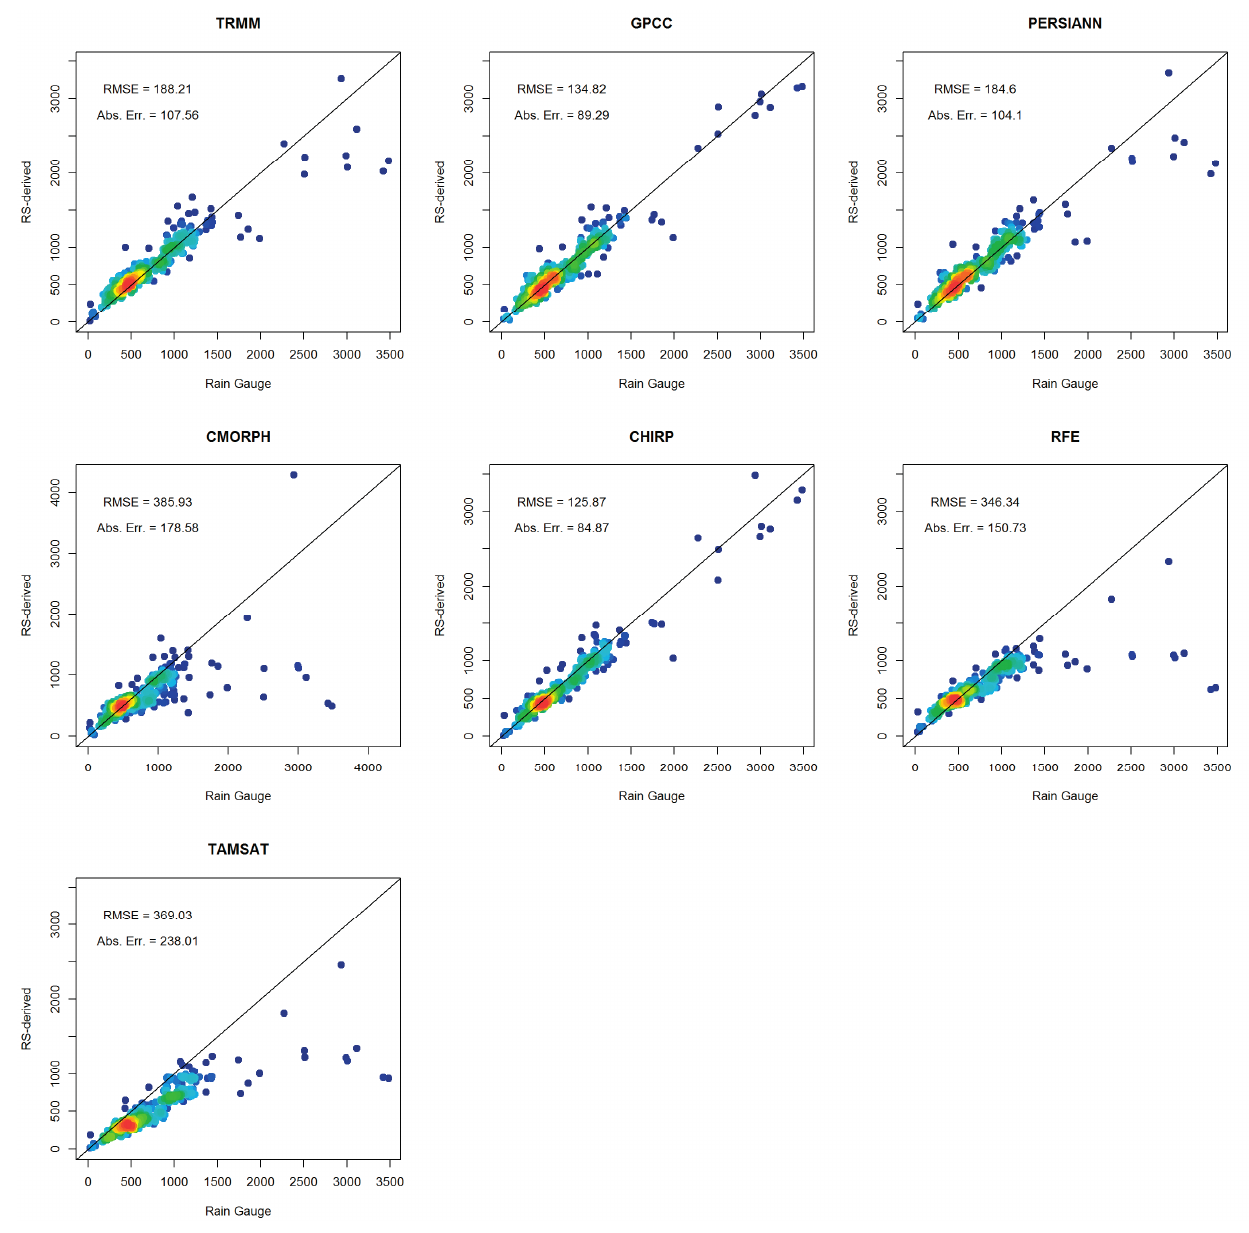
Figure 14. Scatterplot of Rain gauges versus Satellite-derived precipitation for West